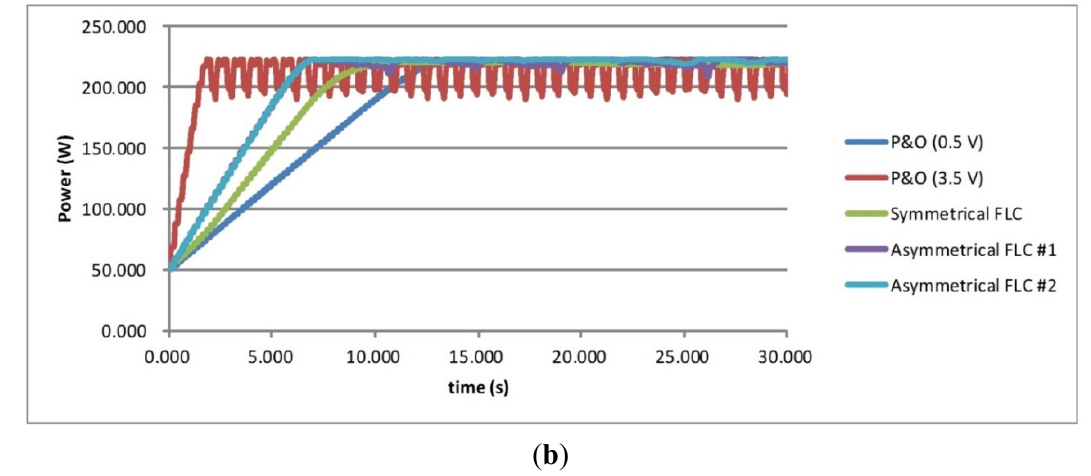
Figure 15. Measured starting waveform of five different algorithms when irradiance level is 1000 W/m 2 (Starting from the left-hand side). ( a ) Simulated results; ( b ) Measured results.